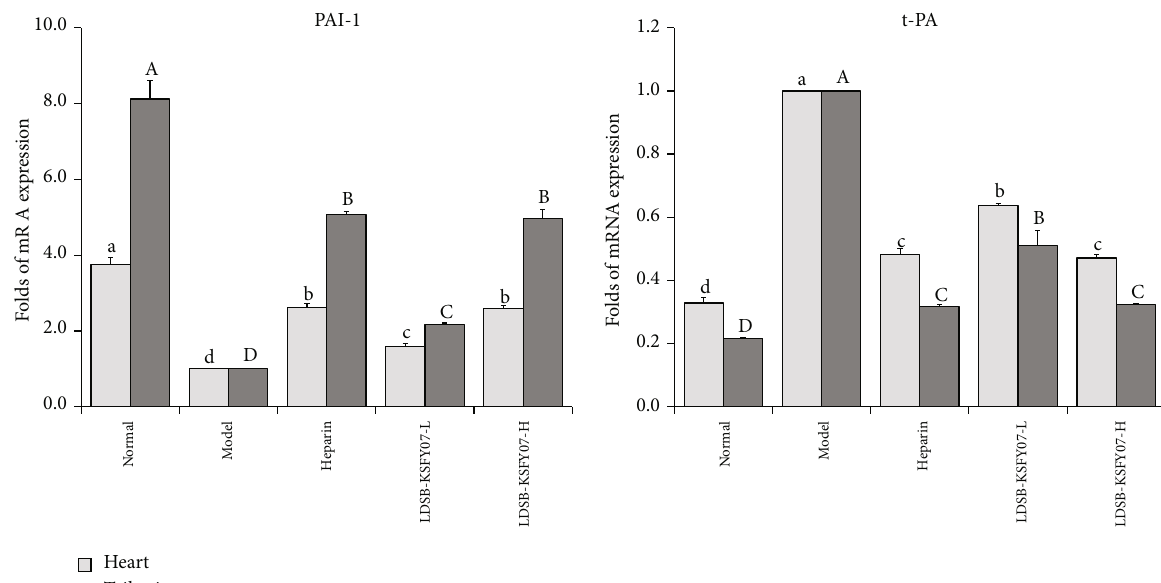
Figure 5: TAI-1 and t-PA mRNA expression in heart and tail vein tissues of mice with kappa-carrageenan-induced thrombosis. The results have been expressed as mean ± deviation . (a – d and A – D) Mean values with di ff erent bars in the di ff erent column are signi fi cantly di ff erent ( P < 0 : 05 ) according to Duncan ’ s multiple range